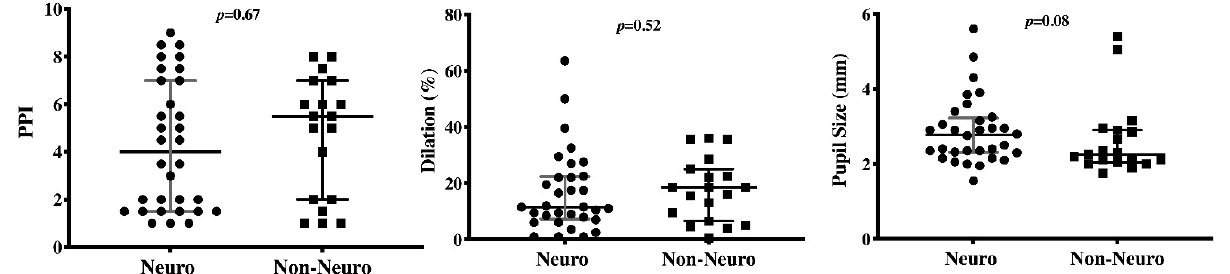
Figure 3. Differences in the pupillary pain index (PPI), the dilation rate (%), and the baseline pupil size (mm) at noxious stimulation between patients with (“neuro”) and without (“non-neuro”) a primary brain injury on ICU admission.